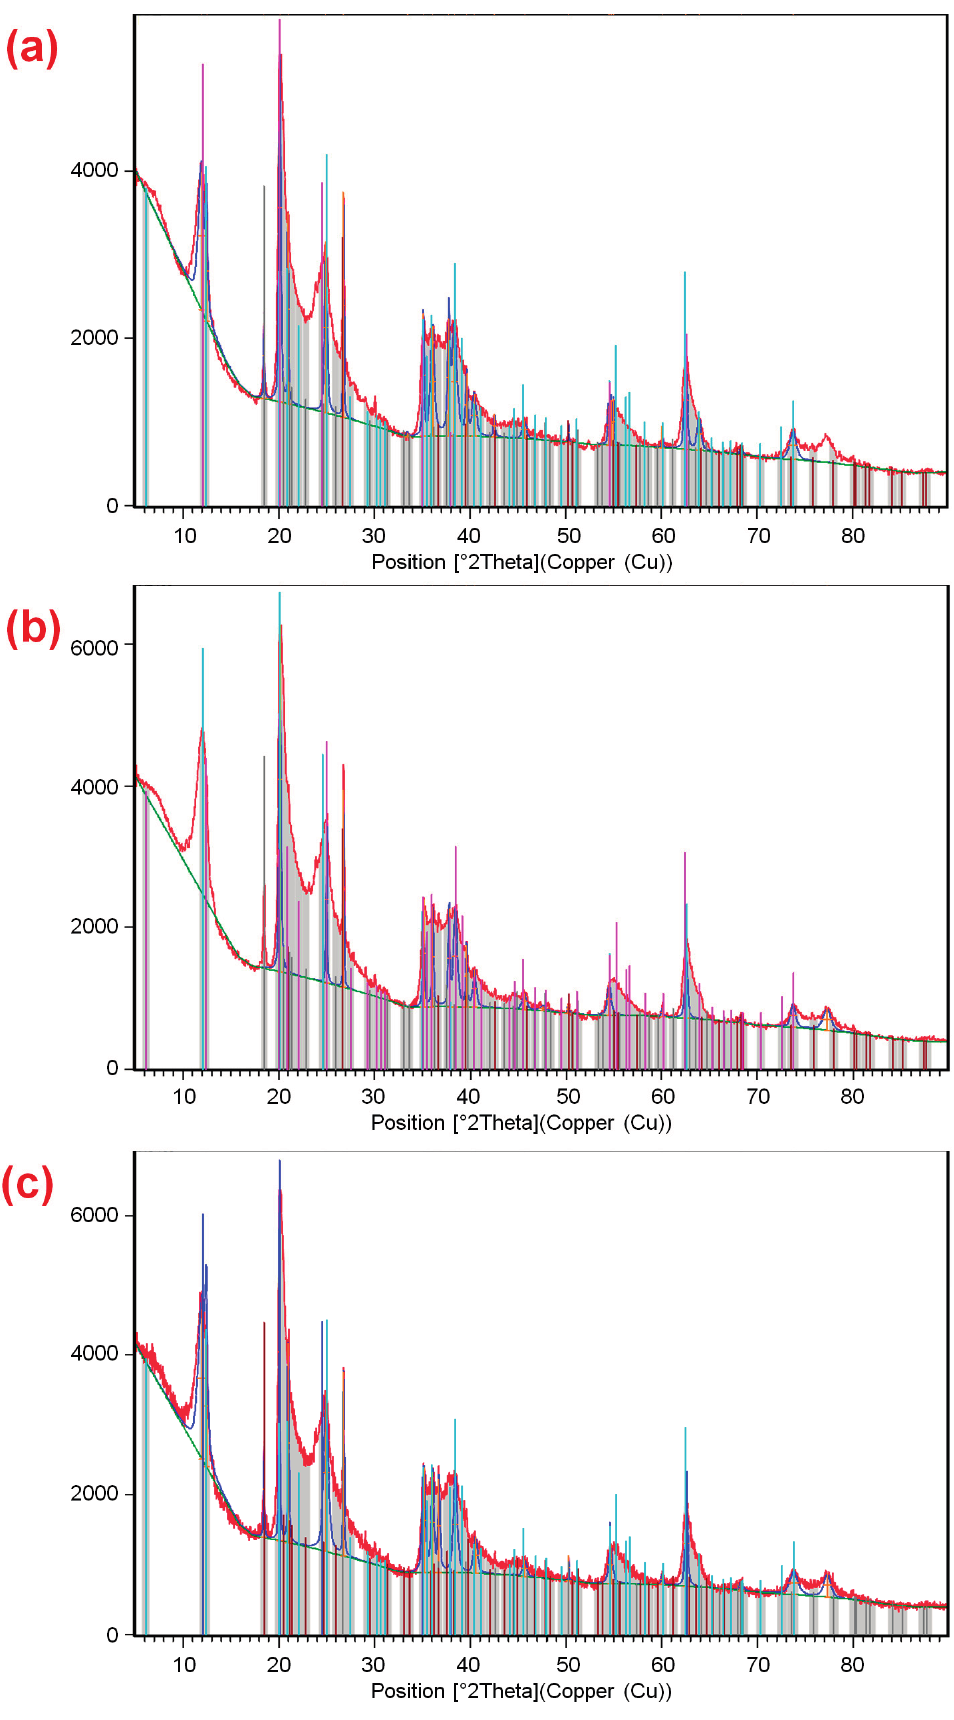
Figure 3. Diffractograms of ( a ) HNTs; ( b ) HNTs–TMPS; ( c )